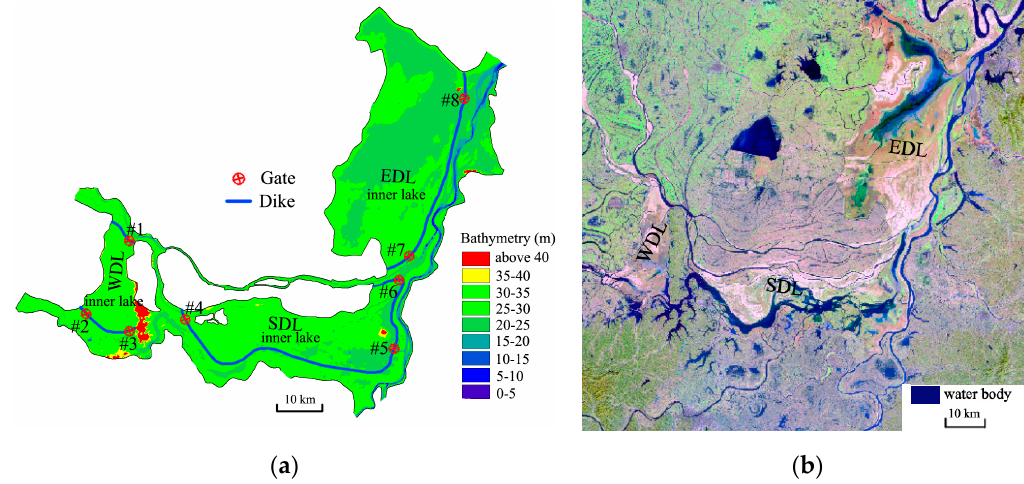
Figure 5. The application of the IFCS in Dongting Lake. ( a ) The layout of the IFCS; ( b ) The water body in the dry season of Dongting Lake (December 2006).